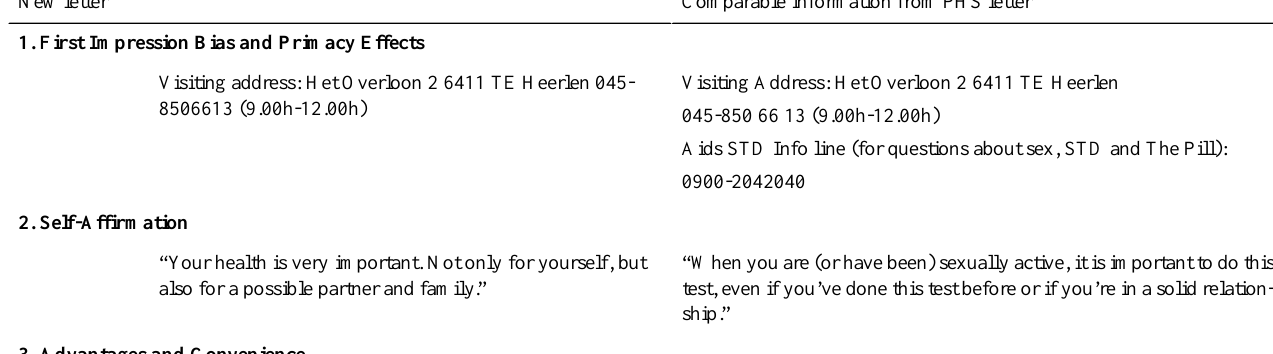
Comparable information from PHS letterNew